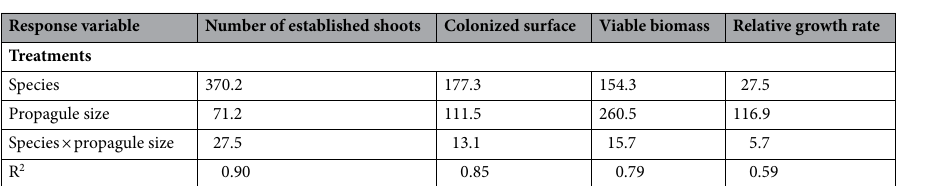
Table 1. Results of the analysis of deviance testing the effect of species, propagule size and their interaction on the indicators of establishment success (number of established shoots, colonized surface, viable biomass and relative growth rate). R 2 indicates the proportion of variance explained by the model including all three predictors. All parameters were significant at p <